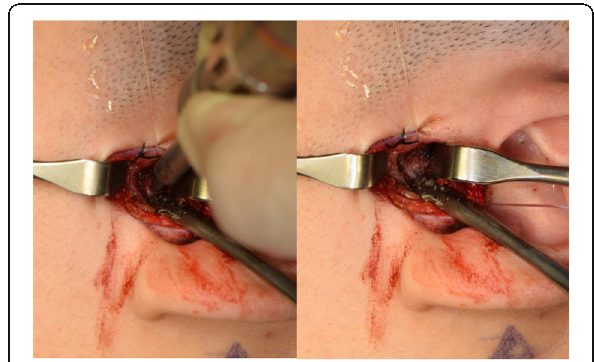
Fig. 6 a , b Initial bone perforation for MITEK mini anchor implant placement located at most lateral, superior, and posterior aspect of mandibular condyle